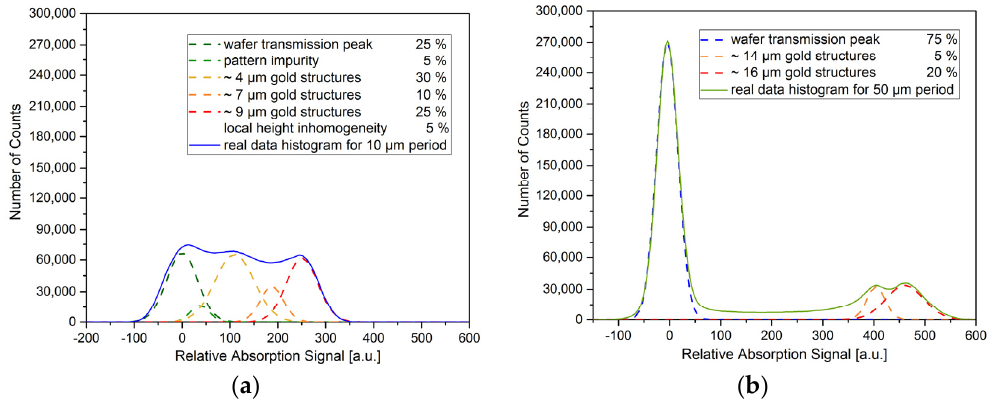
Figure 8. Real data absorption signal histogram decomposed into several Gaussian shape signals correlated to the different height of gold structures: ( a ) for a 10 μ m period grating (small Gaussians were treated as a local gold height inhomogeneity as their content in the entire profile was less than 2% each); and ( b ) for a 50 μ m period grating. In the legends, the percentage of the contribution to the signal was calculated from the areas of the Gaussians used for the approximation of the real data profiles.